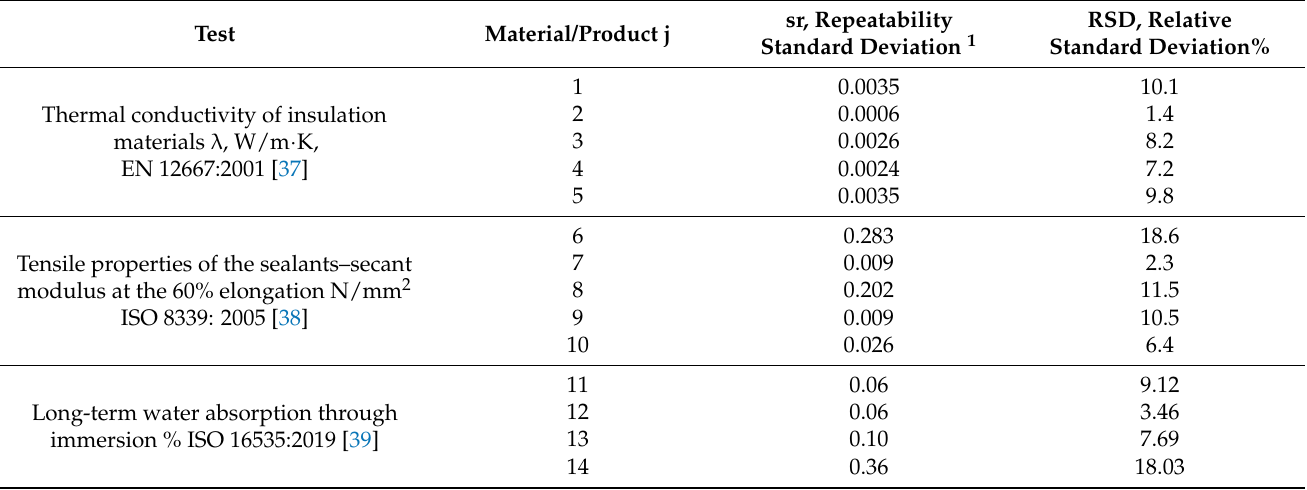
Table 1. Table summarising standard deviations obtained in the current results of tests performed with different methods in the same laboratory. Each value-s r and RSD-was obtained for different construction product test